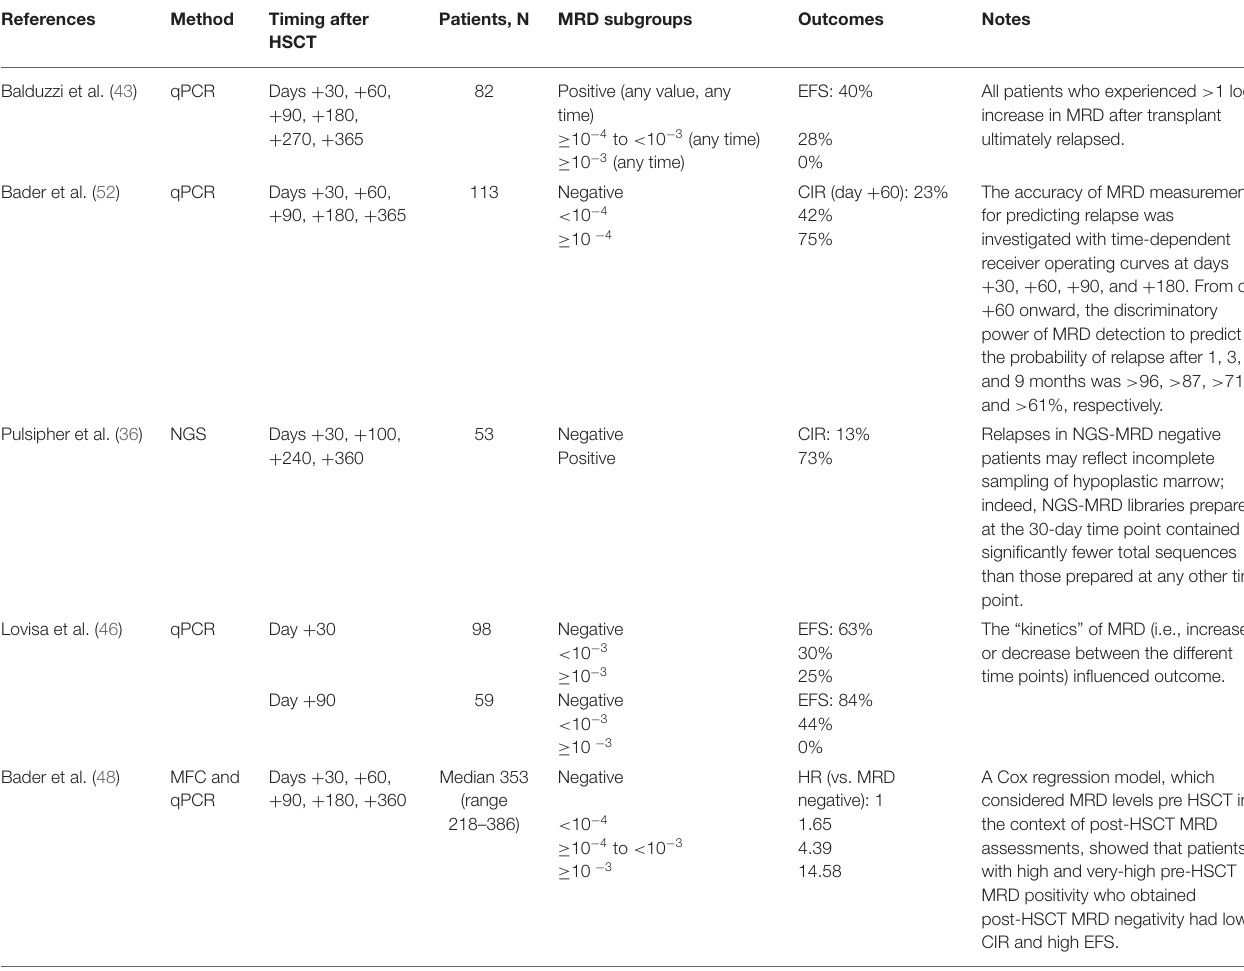
TABLE 2 | Studies of MRD measurement after